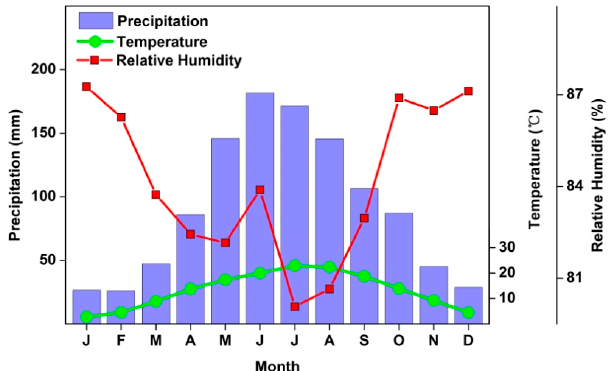
Figure 2. Annual climate conditions for Xi Shui station (see location in Figure 1) from 1960 to 2015 showing total monthly precipitation, mean monthly temperature, and mean monthly relative humidity.